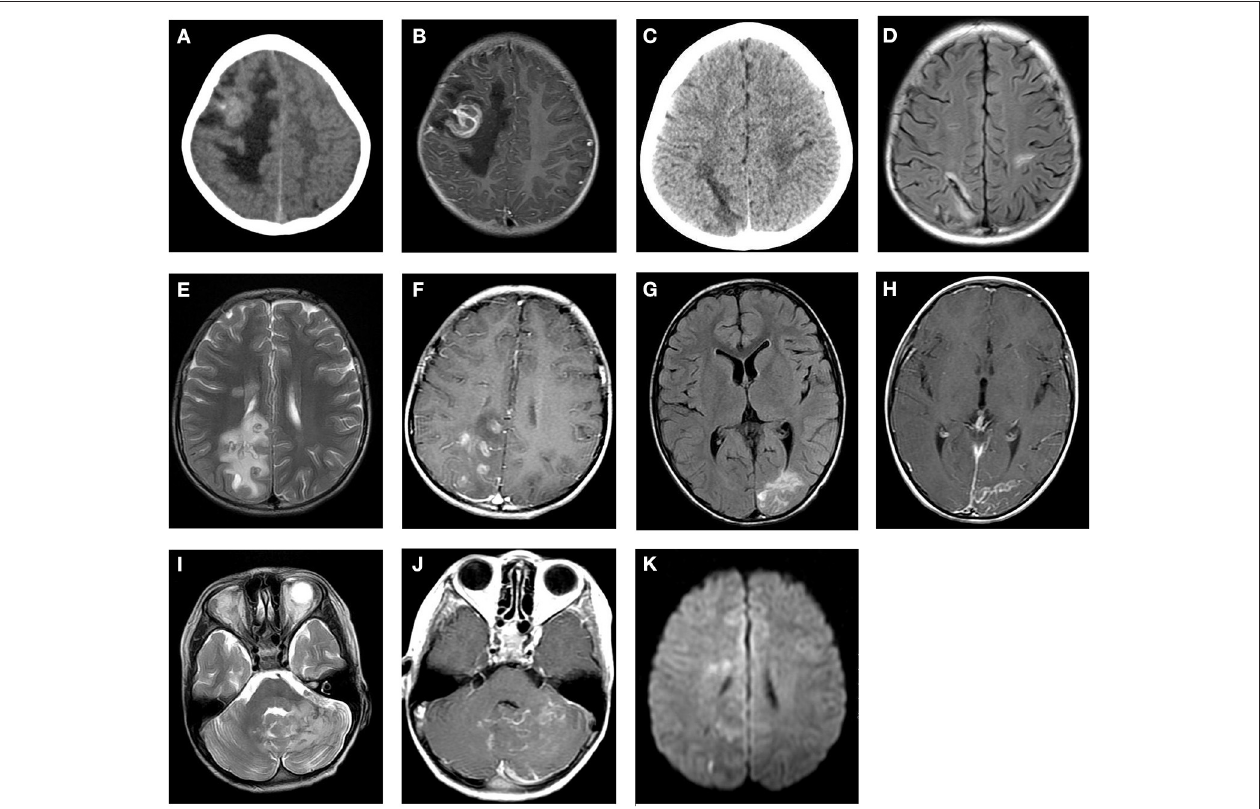
FIGURE 1 | Cranial CT and MRI features of the patients with cerebral paragonimiasis are shown. CT images showed the lesion in the right frontotemporal lobe, which is a mass of equal or slightly high density, surrounded by patchy low-density edema (A) . The T1WI enhancement scans showed that the lesion was a ring-like enhancement, surrounded by edema (B) . CT images showed a strip-like low-density lesion in the right parietal lobe surrounded by mild edema (C) . On the T2/FLAIR images, the lesion was a strip-like low signal surrounded by a high signal, which is the classic “tunnel sign” (D) . On the T2WI scans, the lesion in the right parietal occipital lobe was nodular and a circular low or slightly high signal, accompanied by peripheral patchy edema (E) . The lesions showed obvious nodular and circular enhancement on the T1WI enhancement scans (F) . On the T2/FLAIR images, the left occipital lobe lesions were strip-like and sheet with slightly high signals, and the peripheral edema was not obvious (G) . On the T1WI enhancement scans, the lesion showed strip enhancement (H) . On the T2WI scans, the left cerebellar hemisphere showed an uneven increased signal, which had nodular and striped mixed signals with unclear boundaries (I) . On the T1WI scans, the lesions showed ring-like and strip-like enhancements, and the adjacent meninges were thickened and significantly enhanced (J) . On the DWI scans, an equal or slightly high signal is shown (K) .